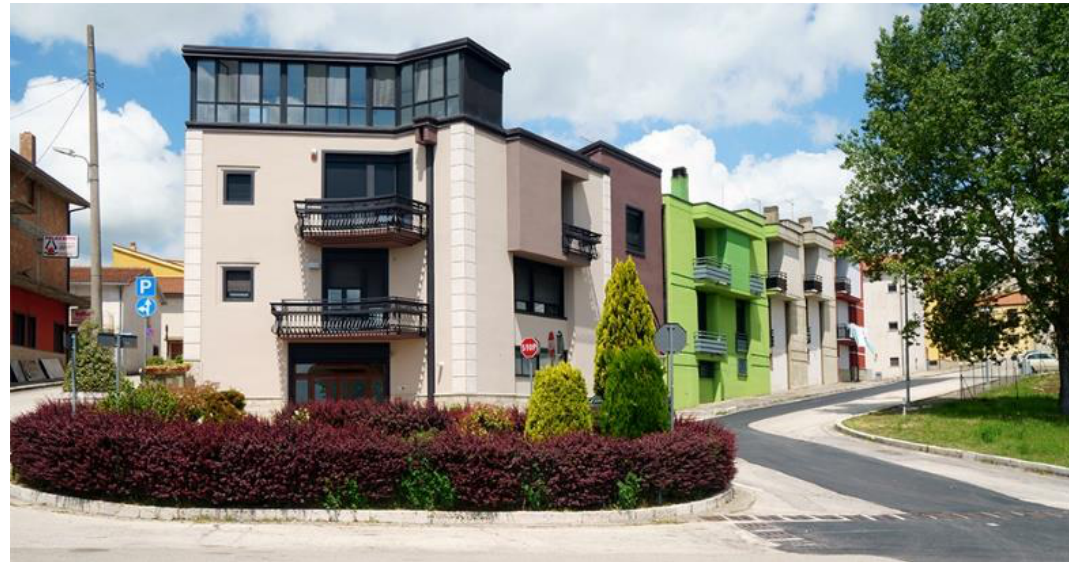
Figure 107. Bisaccia: the new village (Piano di Zona) with a detail of the new reinforced concrete homes designed by the architect A. L. Rossi, (photos by [41]).